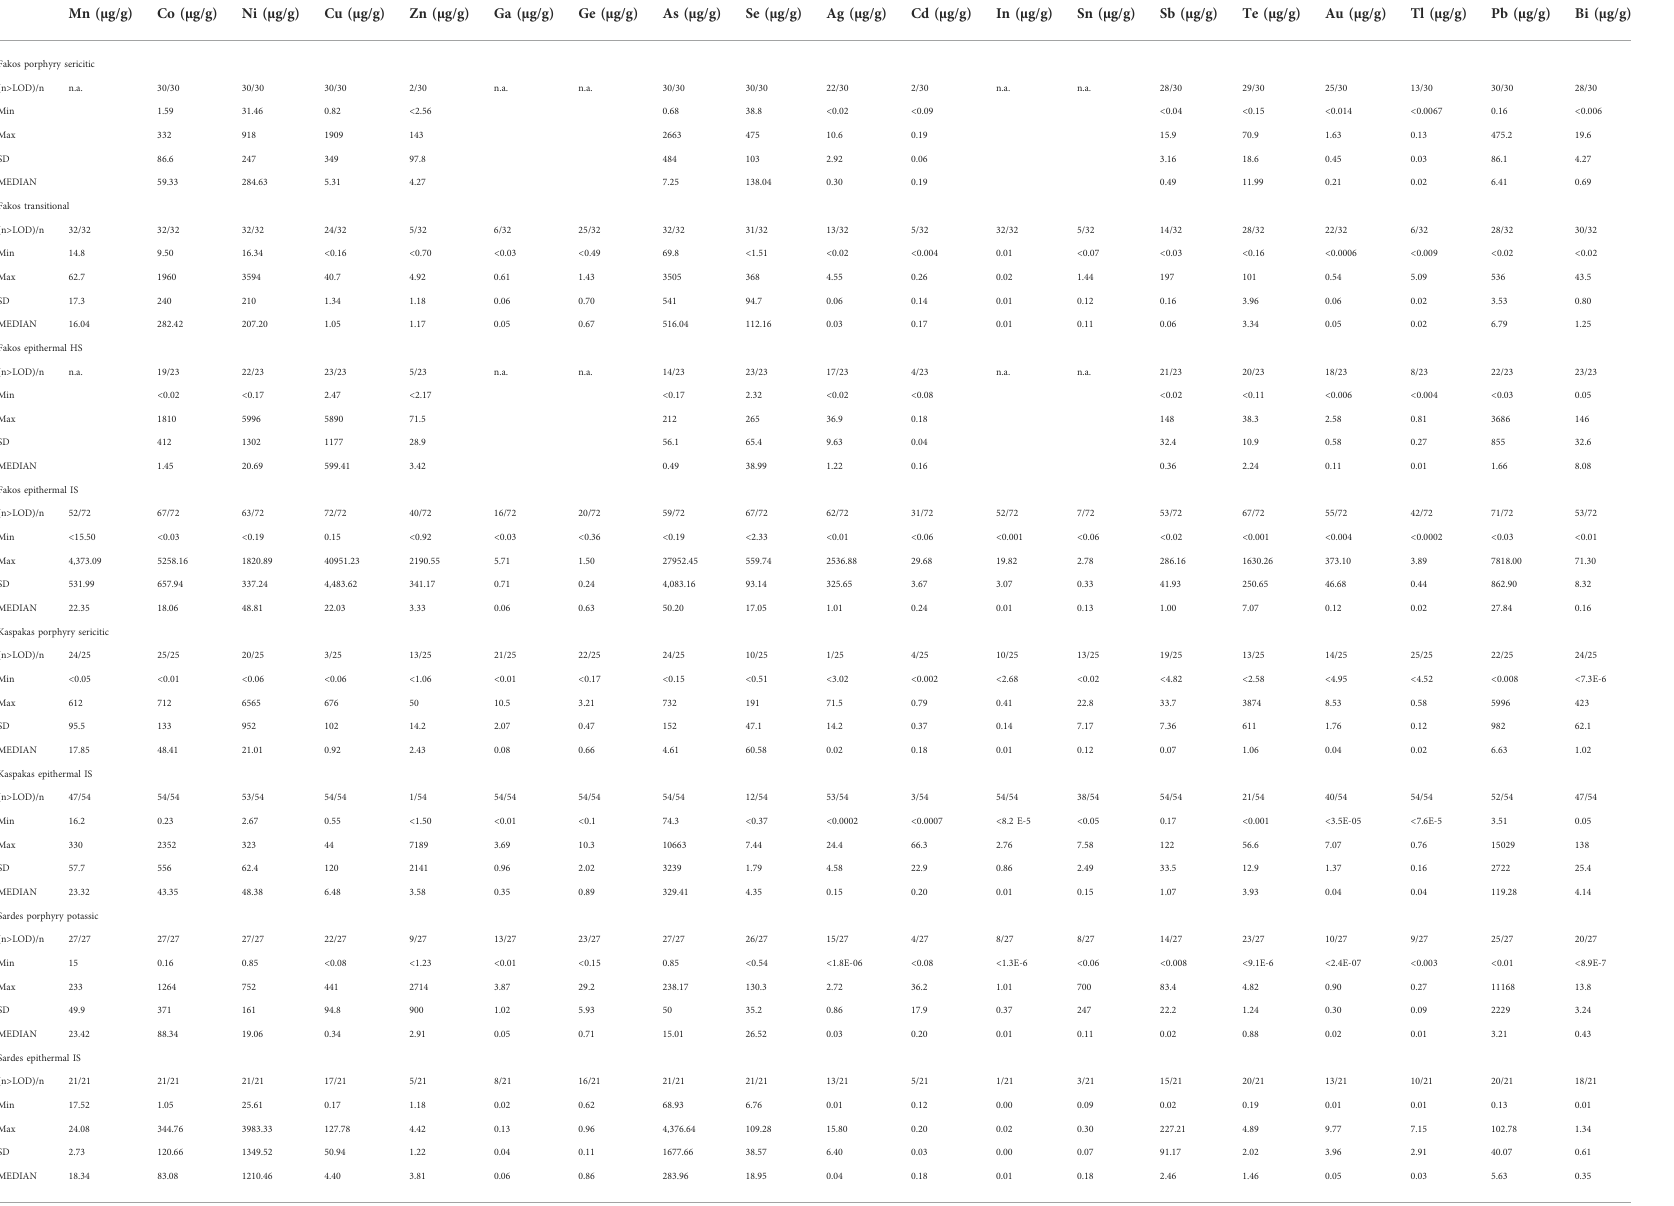
TABLE 4 Summary of pyrite results from LA-ICP-MS